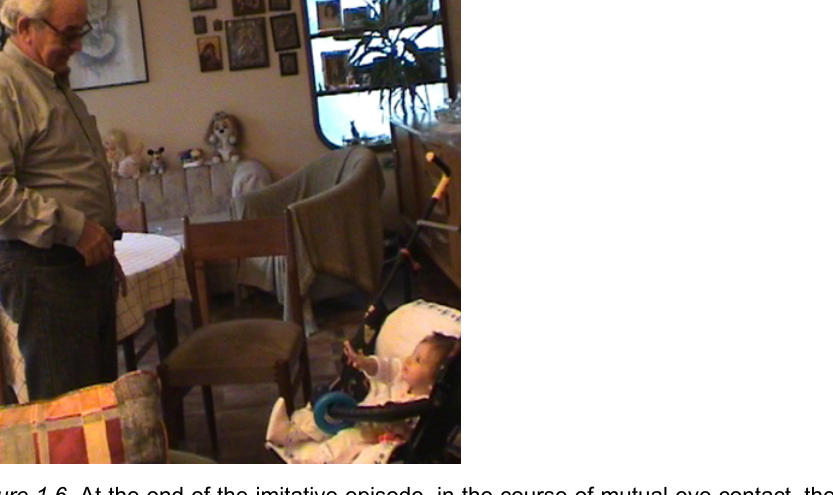
Figure 1.6. At the end of the imitative episode, in the course of mutual eye contact, the grandfather is expressing a relaxed “pleasure” emotional